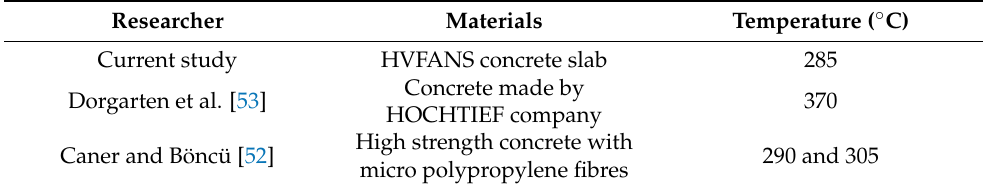
Table 3. Comparison of temperature recorded at depth 60 mm after 2 h heating in previous studies.